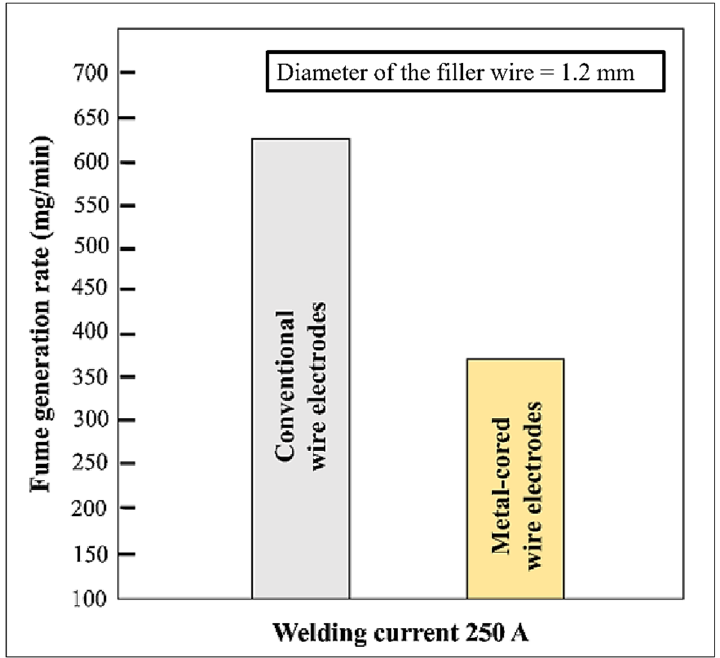
Figure 2. Fume generation: conventional filler wires vs. metal cored filler wires [20].